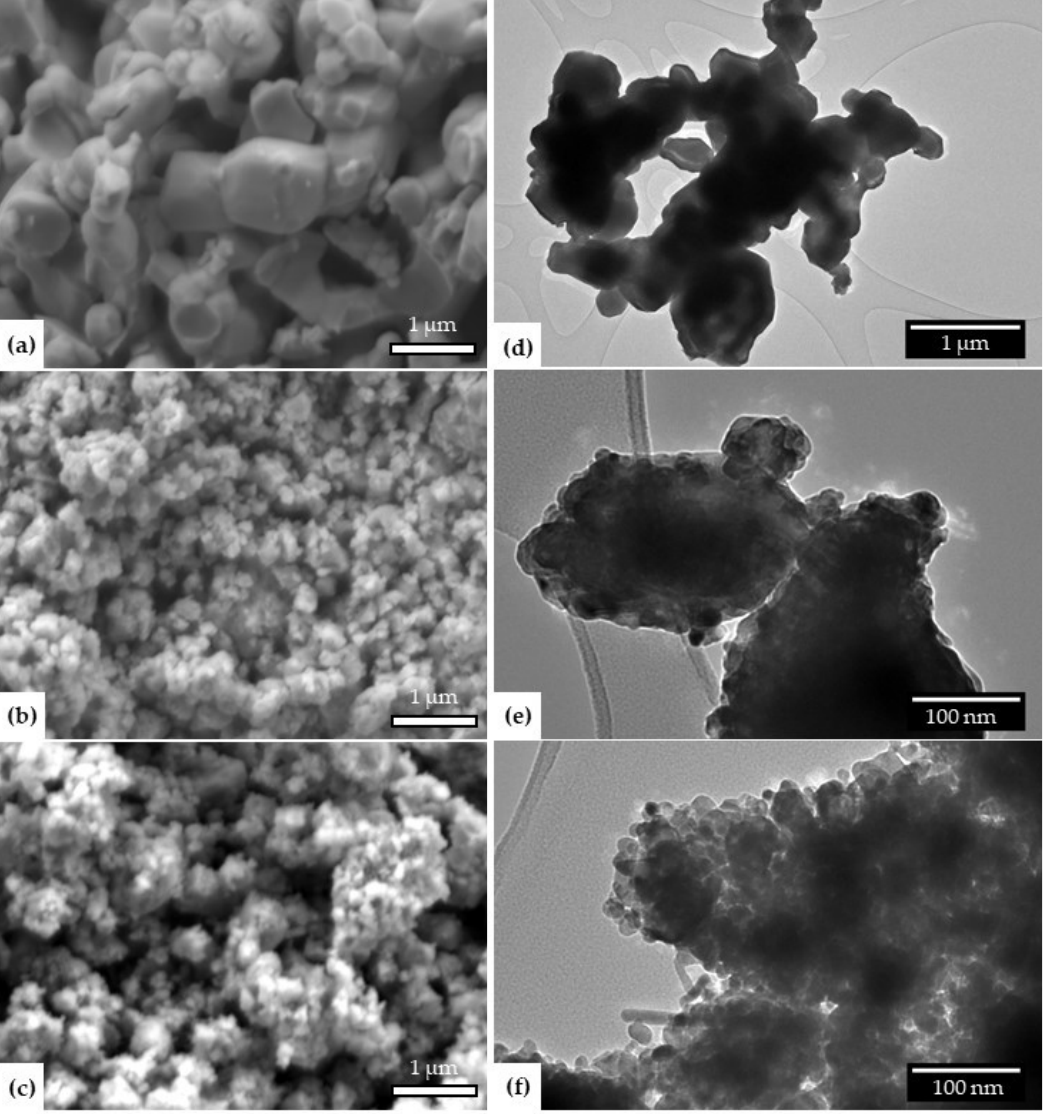
Figure 3. Scanning electron microscope (SEM) images obtained for LaMnO 3.15 (left) and transmission electron microscope (TEM) images obtained for LaFeO 3 (right), after each synthesis steps. ( a, d ) SSR: solid state reaction, ( b, e ) HEBM: high-energy ball milling, ( c, f ) LEBM: low-energy ball milling.